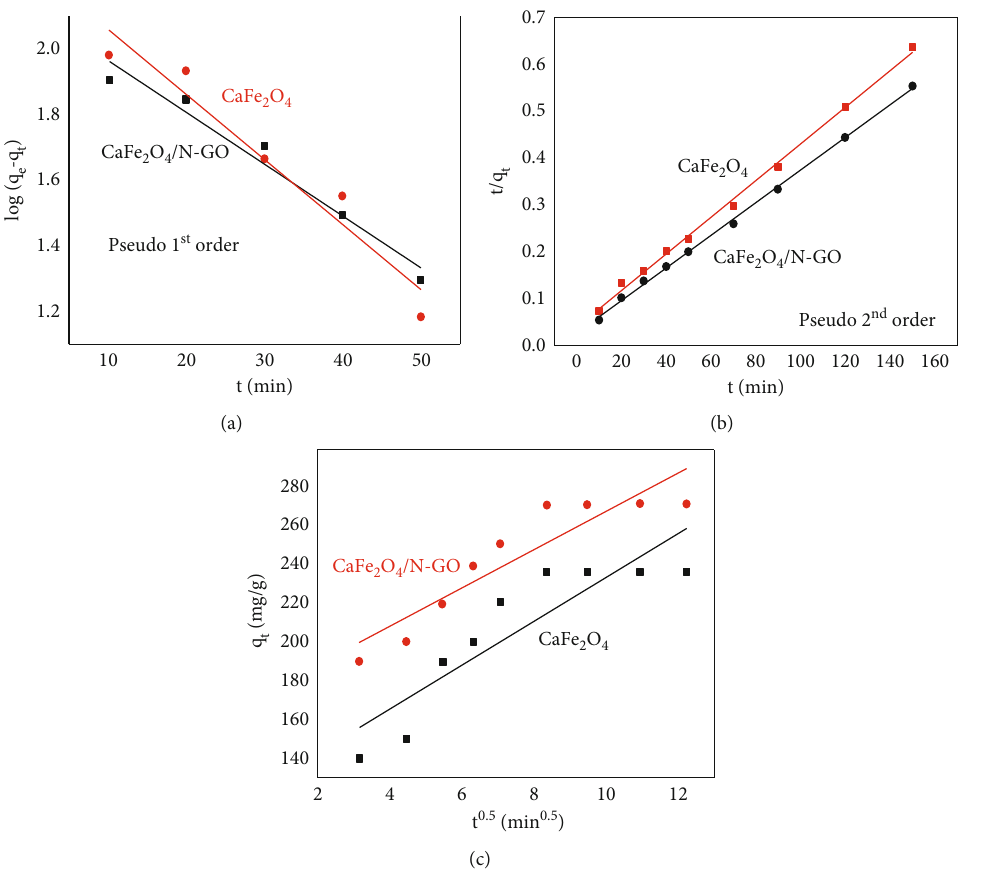
Figure 7: Fitting the experimental data to pseudo 1 st order kinetics (a), pseudo 2 nd order kinetics (b), and intraparticle di ff usion model (c) for the adsorption of RO12 dye on the surface of CaFe